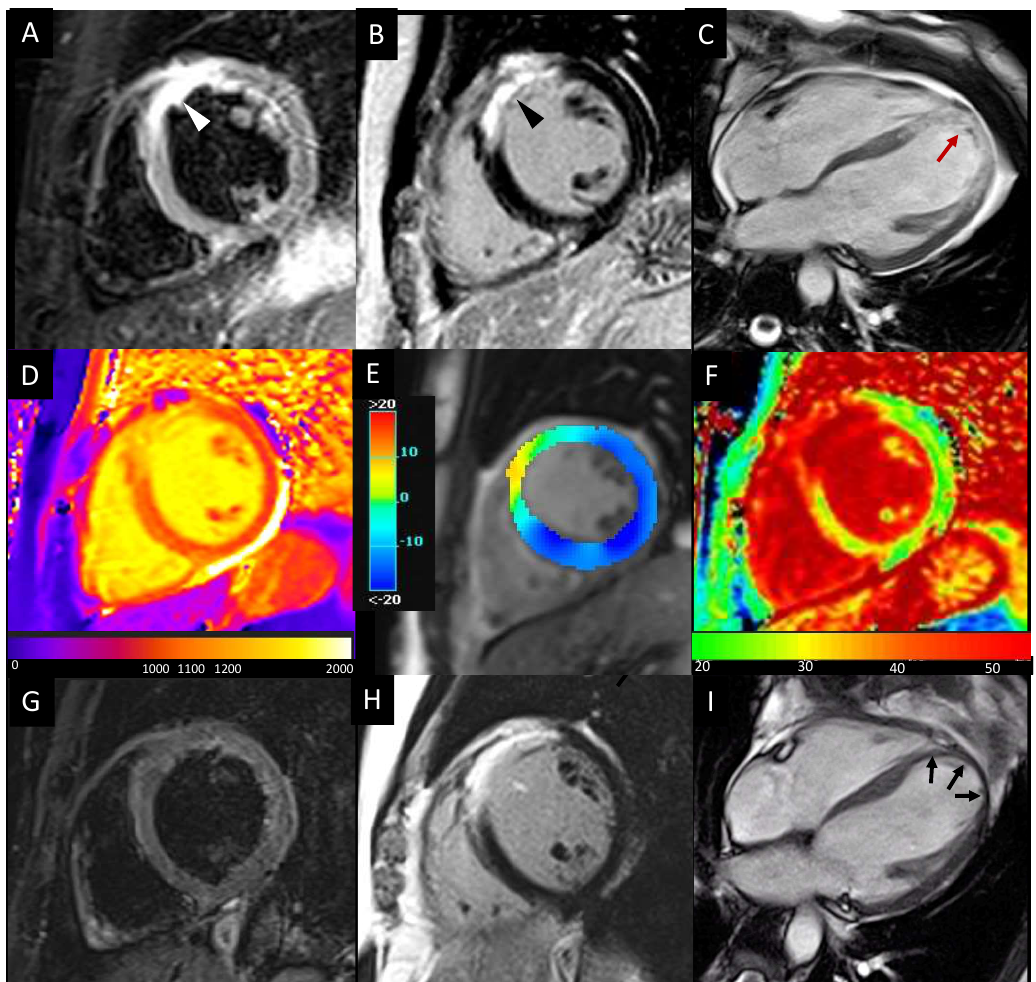
Figure 2. Cardiac magnetic resonance images of LV anterior myocardial infarction due to left anterior descending artery occlusion, acquired during the subacute phase ( A – F ) and six-month FU ( G – I ). T2-w STIR ( A ) and LGE ( B ) images acquired on the mid-ventricular short axis view show myocardial edema (white arrowhead) and necrosis (black arrowhead), respectively, of the antero-septal wall. Cine MR images acquired in four-chamber view ( C ) show thickening of the damaged LV apical wall due to post-ischemic edema and the presence of a tiny apical thrombus (red arrow). Areas of increased myocardial T1, reduced circumferential strain (CS), and expansion of extracellular volume fraction (ECV) well match the infarcted region, respectively, on the native nT1 ( D ), CS ( E ), and ECV ( F ) maps. FU images demonstrate disappearance of myocardial edema on STIR images ( G ), persistence and shrinkage of the scar on LGE images ( H ), and adverse LV remodeling with thinning of the infarcted walls and rounding of the apex as for aneurysmal evolution (black arrows, I ). LV: left ventricle; STIR: short tau inversion recovery; LGE: late gadolinium enhancement.